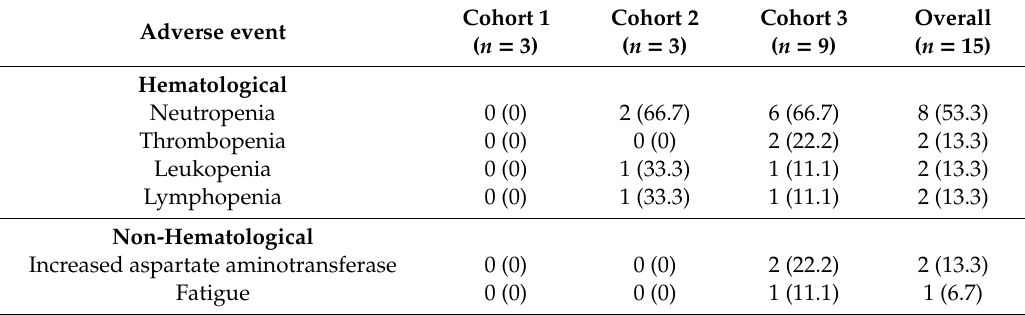
Table 3. Grade 3–5 treatment-related adverse events occurring in the safety population. Cohort 1 Cohort 2 Cohort 3 Overall Adverse event ( n = 3) ( n = 3) ( n = 9) ( n = 15) Hematological Neutropenia 0 (0) 2 (66.7) 6 (66.7) 8 (53.3) Thrombopenia 0 (0) 0 (0) 2 (22.2) 2 (13.3) Leukopenia 0 (0) 1 (33.3) 1 (11.1) 2 (13.3) Lymphopenia 0 (0) 1 (33.3) 1 (11.1) 2 (13.3) Non-Hematological Increased aspartate aminotransferase 0 (0) 0 (0) 2 (22.2) 2 (13.3) Fatigue 0 (0) 0 (0) 1 (11.1) 1